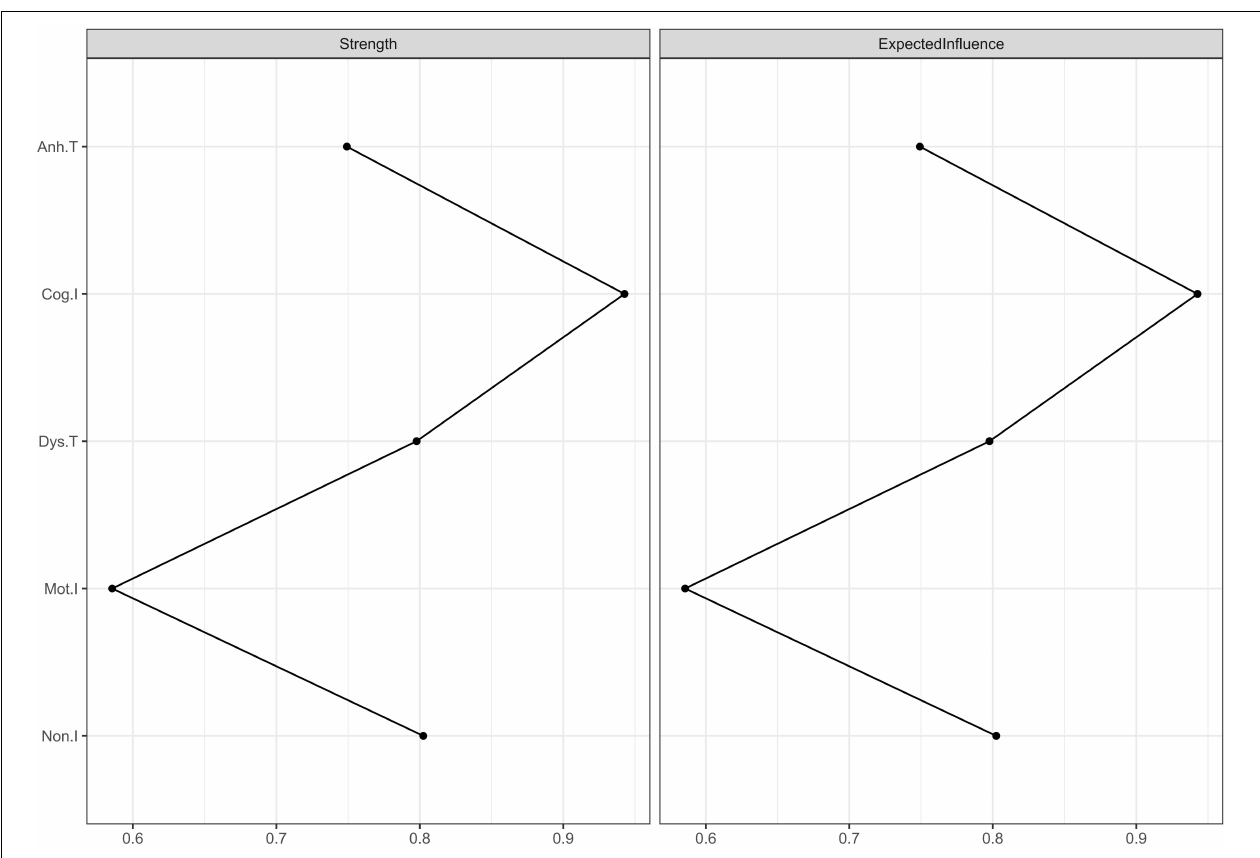
FIGURE 3 | Centrality plots of strength and expected influence. Because there was no negative edge weight in this network, the values of strength and expected influence were the same. The strength and expected influence values are listed in Supplementary Table 3 .